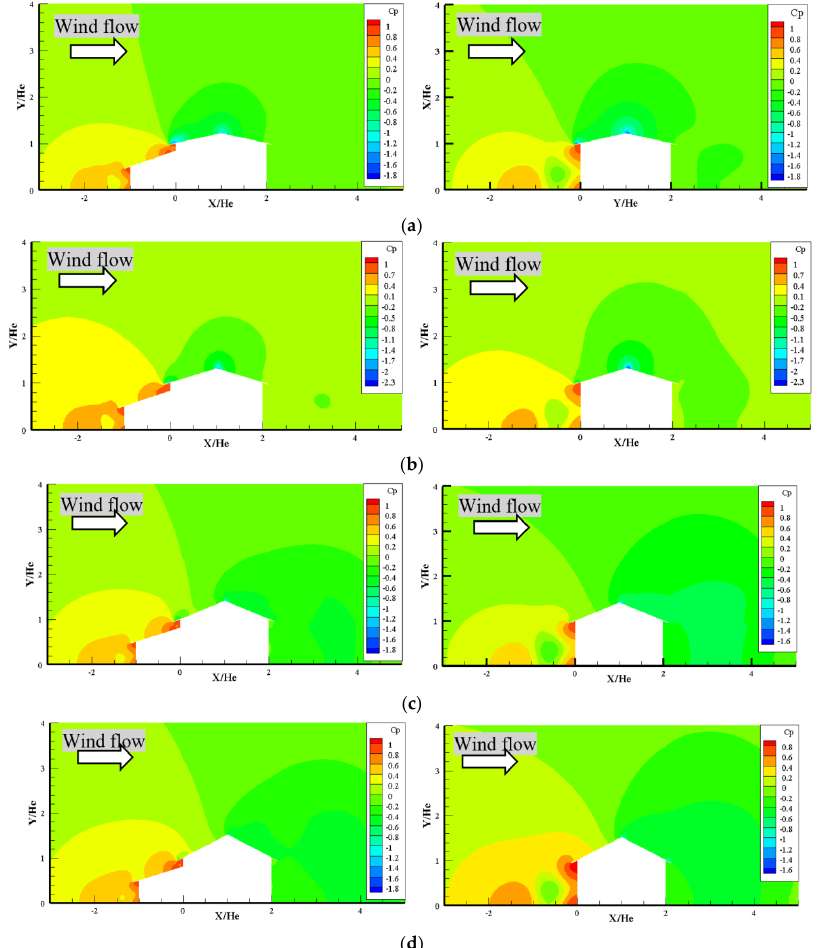
Figure 10. The pressure coefficient contours with roof pitch ( a ) 12°; ( b ) 17°; ( c ) 22°; and ( d ) 27° (note: right side = core house, left side = kitchen house).